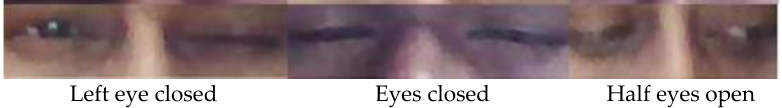
Figure 4. Estimation of head pose for occluded images. ( a ) Right pose; ( b ) Right pose with 45°; ( c ) Front pose; ( d ) Left pose with glasses; ( e ) Left pose.